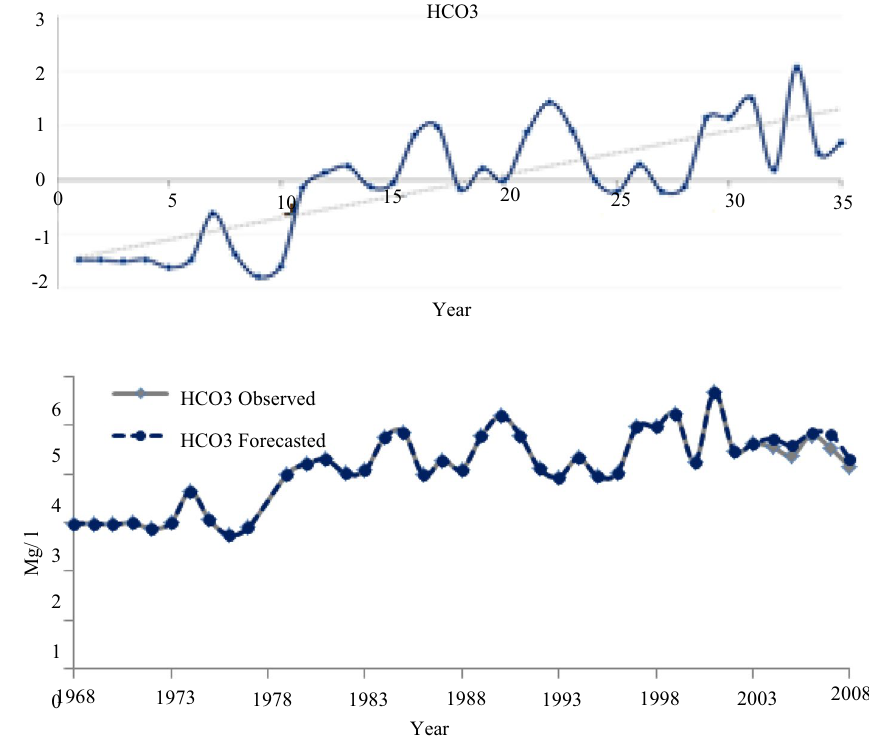
− group, order (1,2) 3 .